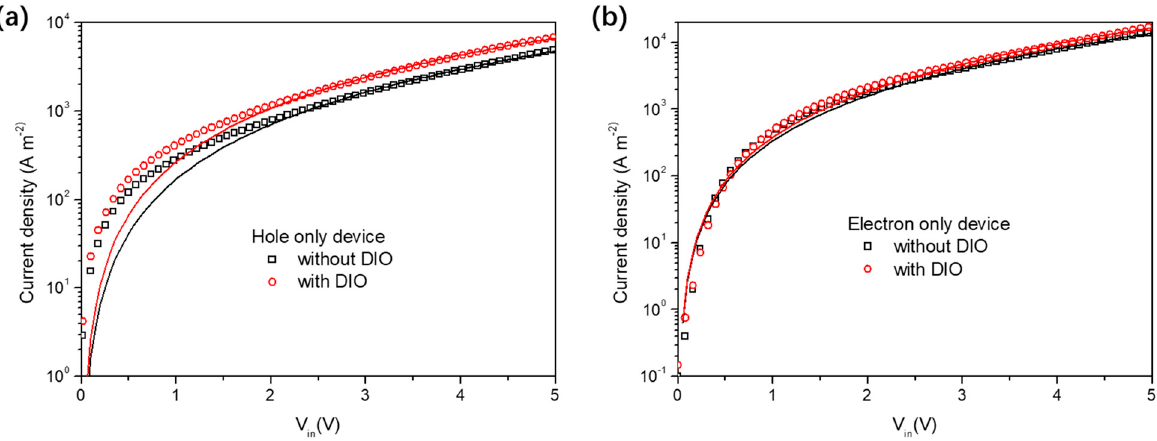
Figure 6. Dark J–V characteristics of PM6:BTP − eC9 − based ( a ) hole − only and ( b ) electron − only ssNP devices. Hole − only device structure: glass/ITO/PEDOT:PSS/NPs/MoO x /Ag; electron − only device structure: glass/ITO/ZnO/NPs/Ca/Ag. The black and red lines were the fitted curves from the Mott–Gurney relation (see Section 2.6).